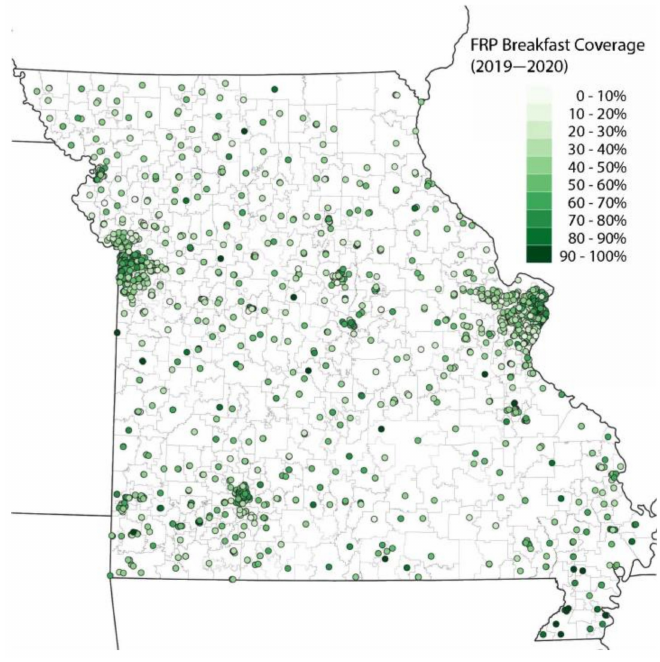
Figure 3. School FRP breakfast coverage (2019–2020).